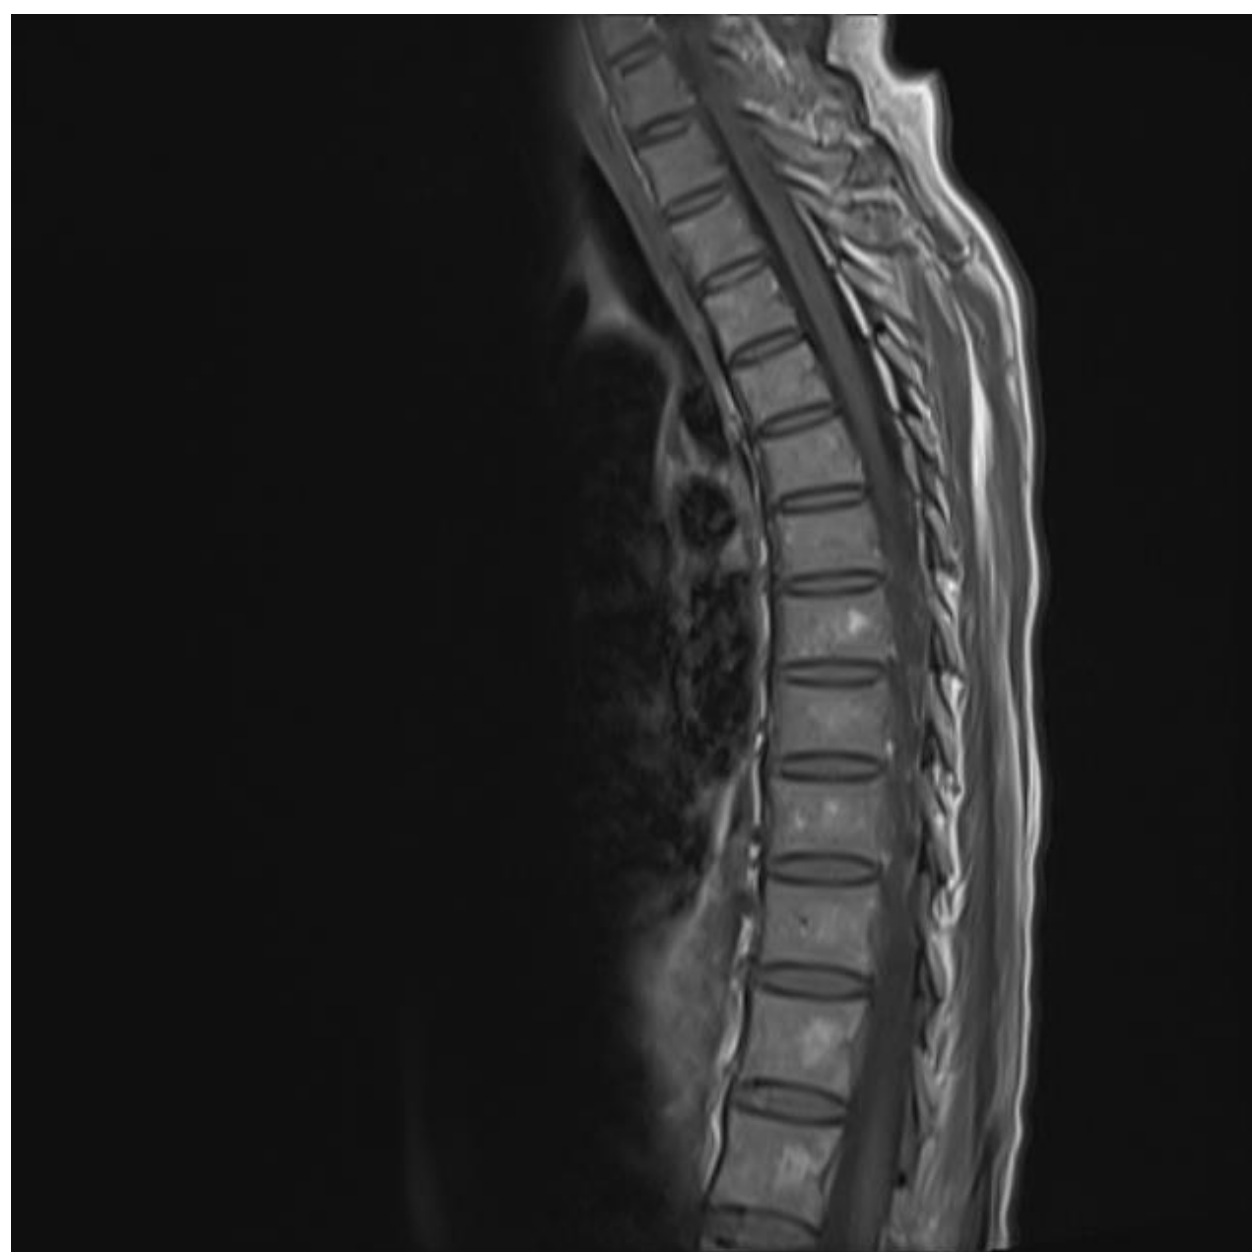
Figure 2. T1 image showing hypodense lesion in the cervical and thoracic cord.